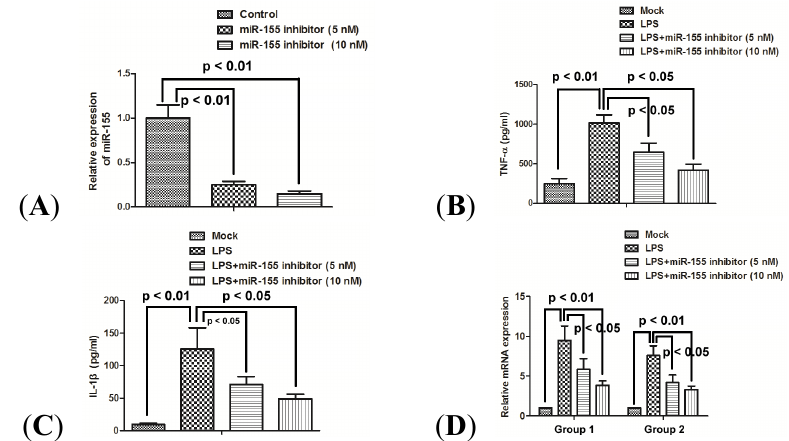
Figure 3. miR-155 inhibitor reduces the production of proinflammatory cytokines induced by LPS. ( A ) Fold changes in miR-155 expression were determined by RT-qPCR 24 h post transfection with 50 nM miRNA inhibitor control, 25 or 50 nM miR-155 inhibitor; ( B ) and ( C ) Expression of TNF- α and IL-1 β in supernatant of PBMCs 24 h after LPS treatment, or (and) 24 h post transfection with 5 nM miR-155 inhibitor or 10 nM miR-155 inhibitor. Results were expressed as pg/mL by an ELISA test; and ( D ) mRNA expression of TNF- α (group 1) and IL-1 β (group 2) in PBMCs 24 h after LPS treatment, or (and) 24 h post transfection with 10 nM miRNA inhibitor control, 5 nM miR-155 inhibitor or 10 nM miRNA inhibitor. All results are the average of three independent experiments. Statistical significance is